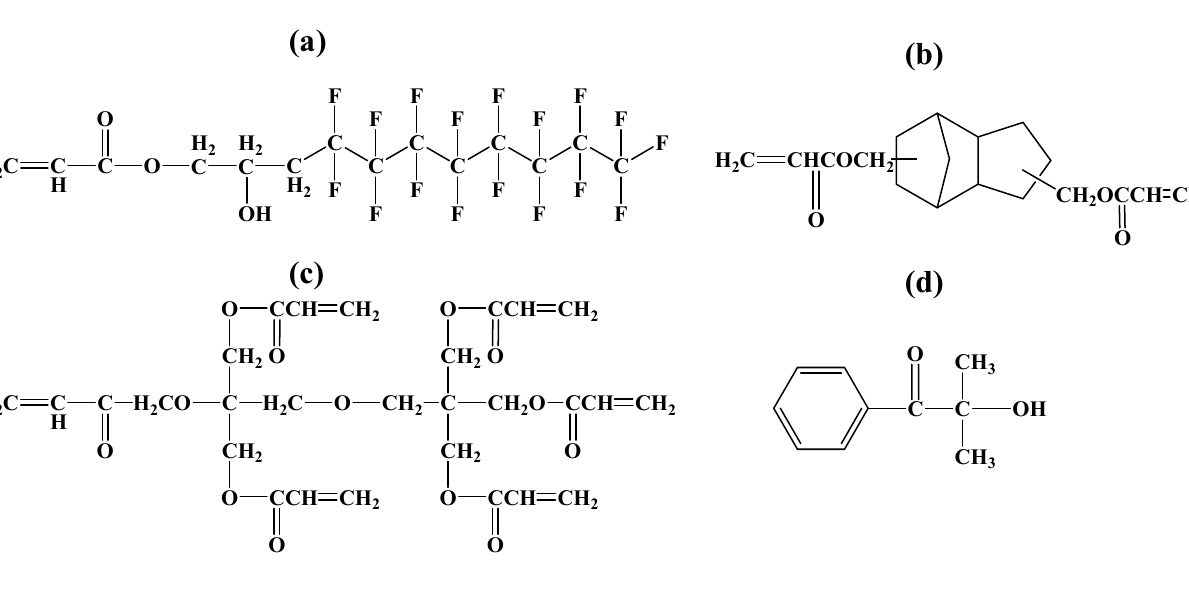
Figure 3. Chemical structures of the nanoimprint resist material containing a UV reactive fluorine surfactant: ( a ) heptadecafluoro-2-hydroxyundecyl acrylate; ( b )